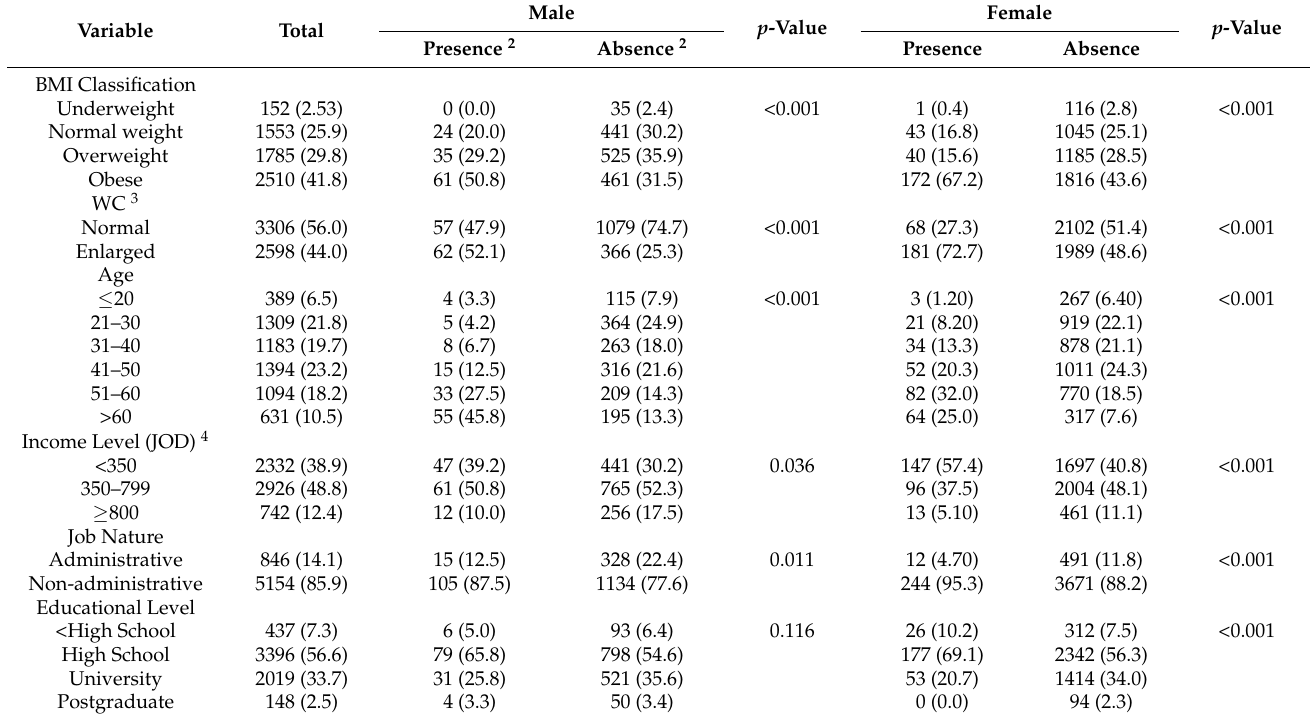
Table 4. CVD relation with BMI, WC, and population characteristics stratified by sex 1